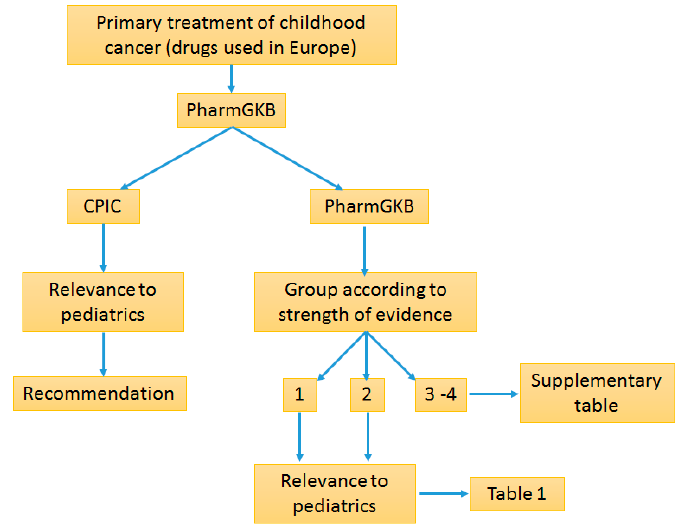
Figure 1. Methodology flow chart.